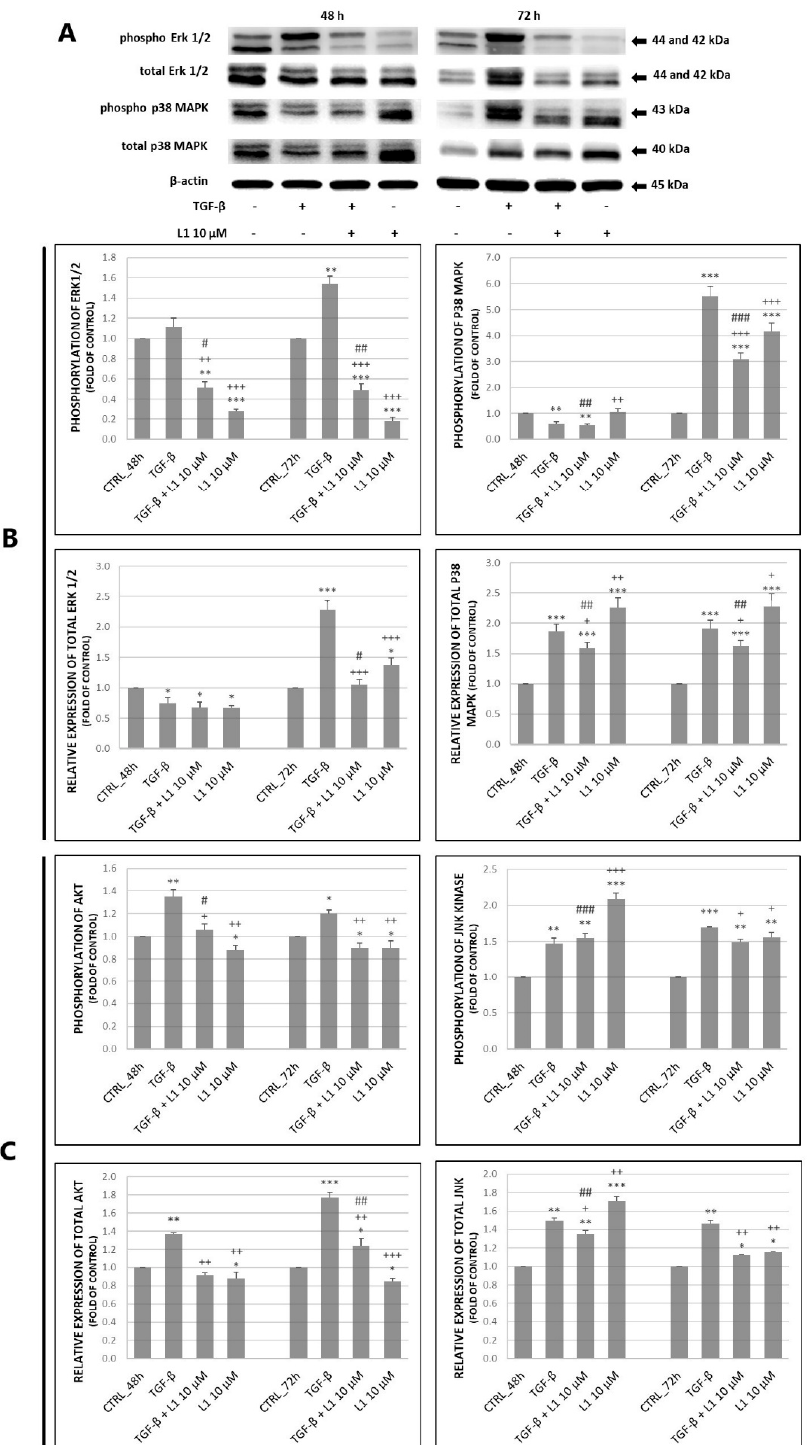
decreased expression and phosphorylation of individual proteins in most cases (Erk1/2, Akt) compared to control groups.